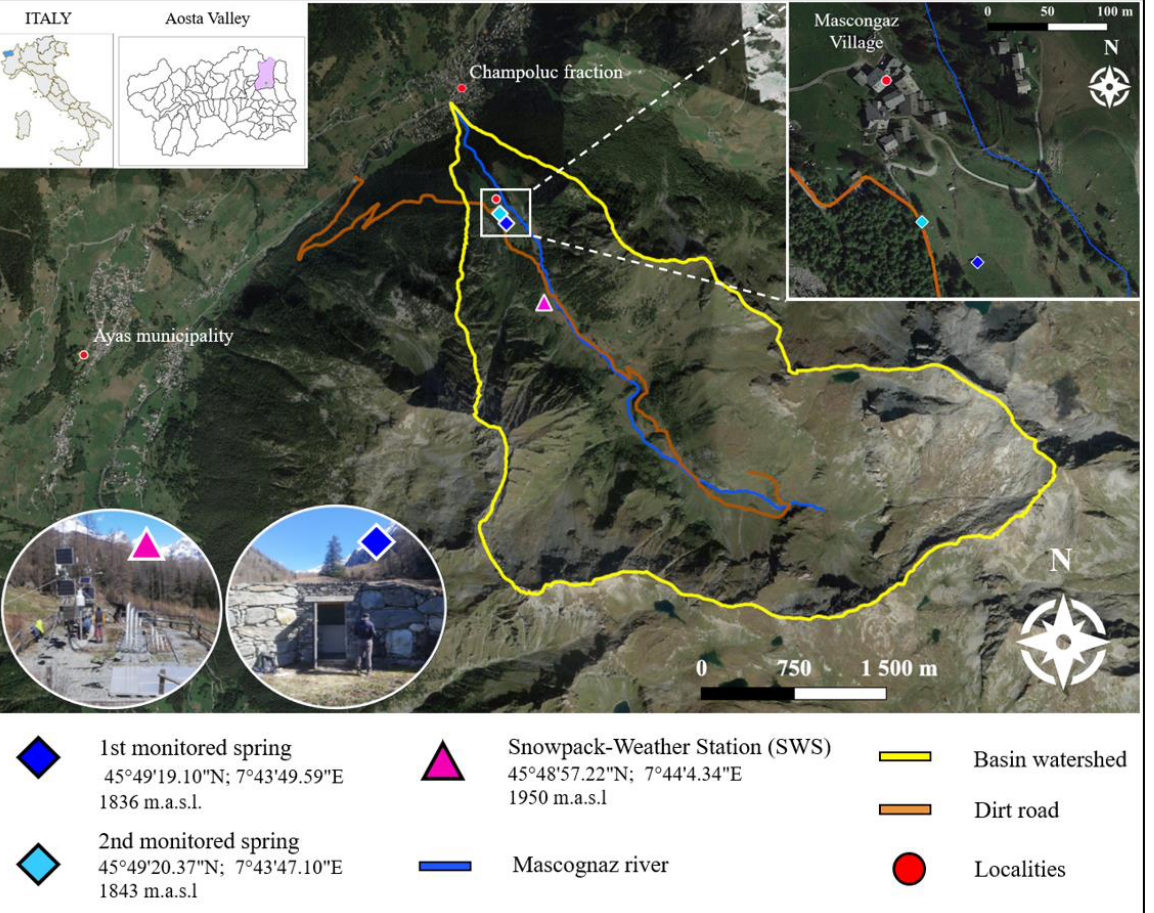
Figure 1. Mascognaz 1 and 2 springs and experimental meteorological station locations.